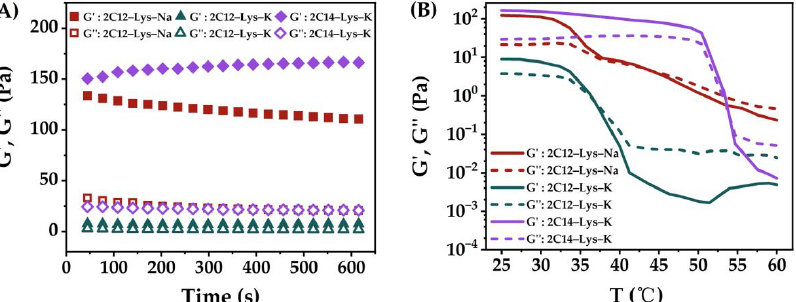
Figure 6. Rheological behaviors of gels formed by 2C12-Lys-Na in water: ( A ) Variation of storage modulus (G’) and loss modulus (G″ ) with time; ( B ) dependence of the stor age modulus (G’) and loss modulus (G ″ ) with the temperature. Table 3. The phase transition temperature of gels formed by L -lysine-based gelators. Solvents